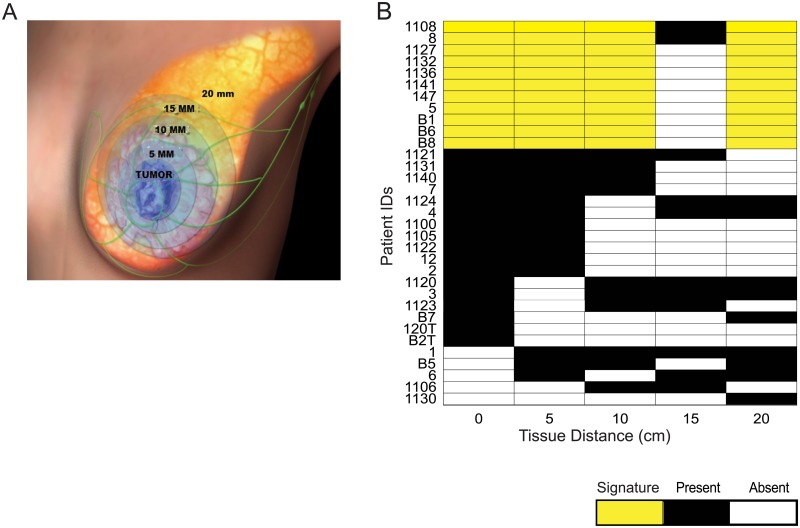
Methodology for tissue sampling.(A) Tissue samples were obtained from tumor (0 mm) and tumor adjacent tissue at 5 mm, 10 mm, 15 mm, and 20 mm away from the pathologic gross tumor edge defined as the margin devoid of cancer cells. (B) Samples from tumor at 5 mm, 10 mm 15 mm, 20 mm collected from each patient. At certain distances specimens could not be obtained due to anatomic considerations (blood vessels, adipose tissue, chest wall). Panel also shows discreet segregation into two groups, tumor (black shading) and non-tumor (white shading). Present indicates the patient had a sample used for data analysis obtained at a particular distance. Absent indicates that tissue at a particular distance was unable to be used for data generation. Tissue samples in yellow were used to derive tumor and tumor-like gene signatures.